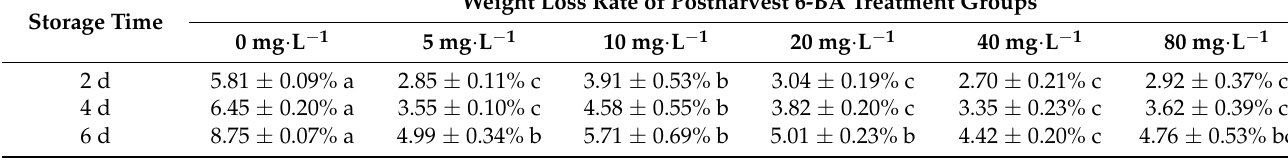
Table 1. The weight loss rate of Chinese flowering cabbage affected by postharvest treatment of different concentrations of